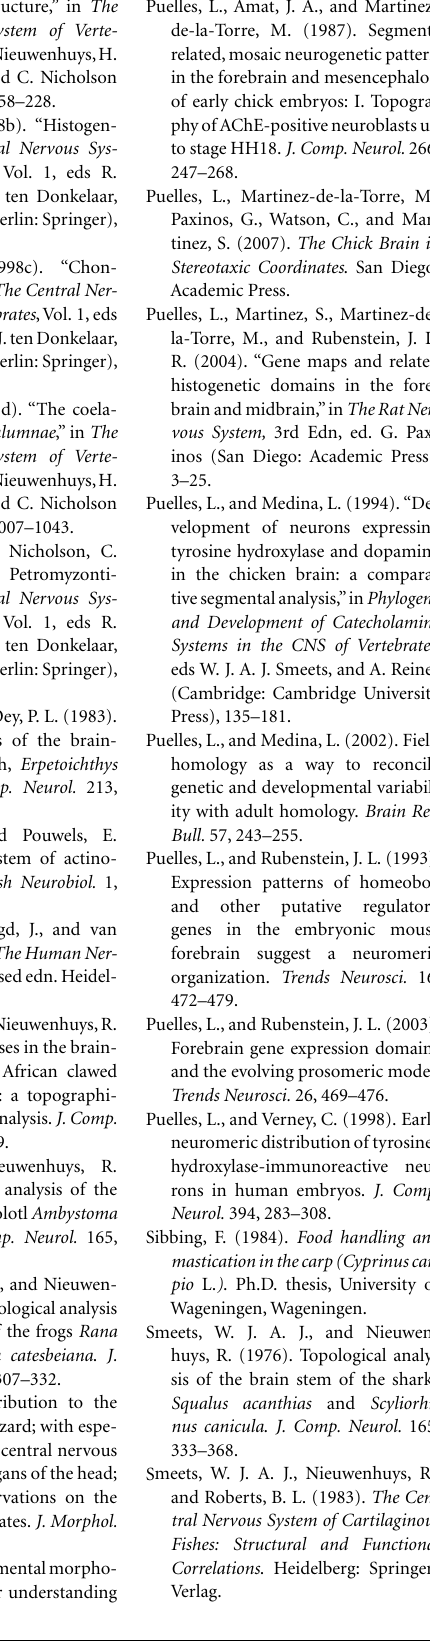
Figdor, M. C., and Stern, C. D. (1993). Segmental organization of embry- onic diencephalon. Nature 363,